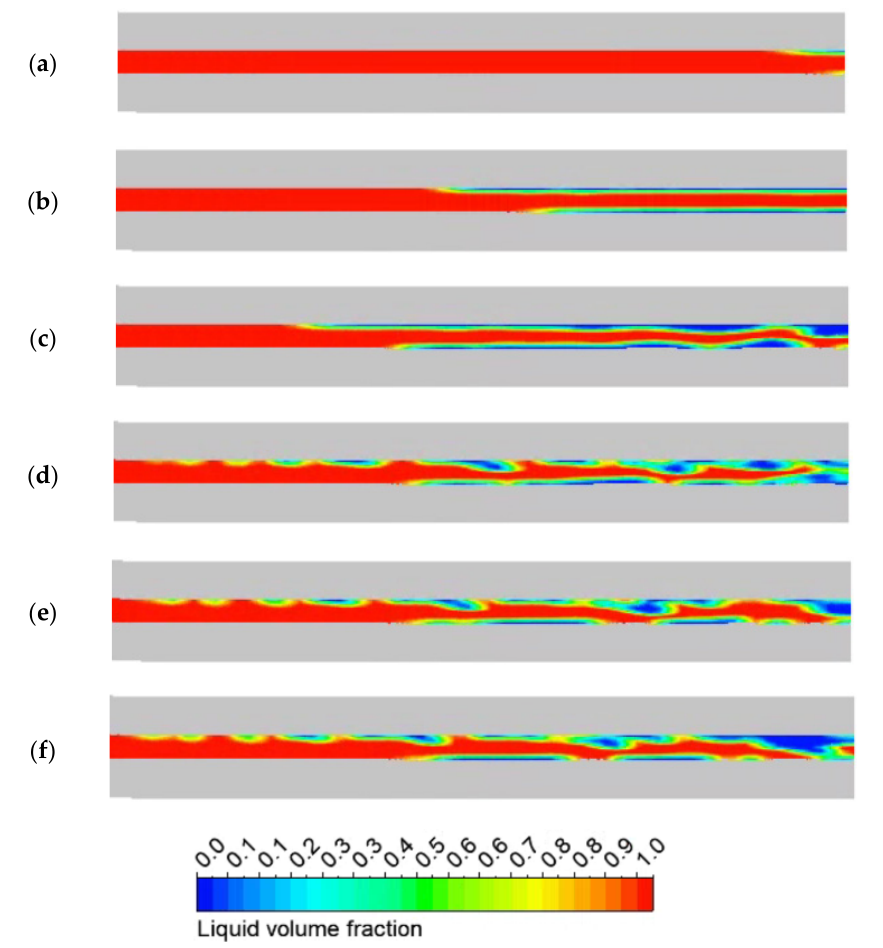
Figure 11. Vapor bubble distributions on axial plane of the capillary at different times: ( a ) 0.01 s ( b ) 0.05 s ( c ) 0.10 s ( d ) 0.15 s ( e ) 0.20 s ( f ) 0.25 s. ( b ) 0.05 s ( c ) 0.10 s ( d ) 0.15 s ( e ) 0.20 s ( f ) 0.25